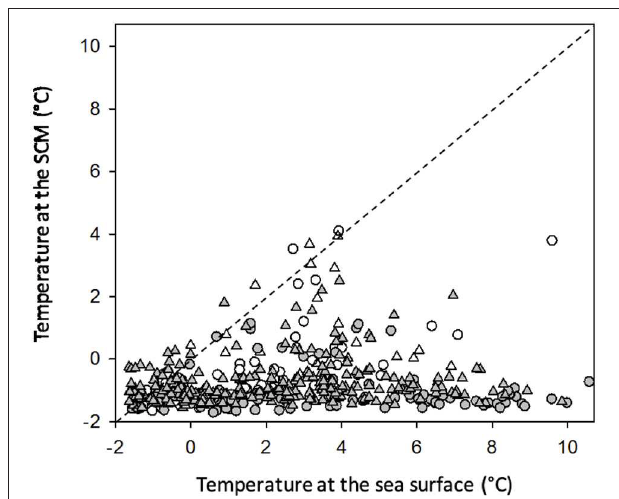
FIGURE 5 | Water temperature at the sea surface and at the depth of the fluorescence maximum for the 547 stations where a clear SCM was present. Sampling locations include the entire Canadian Arctic and cover the period 2005-2018 ( Amundsen Science Data Collection, 2018). Stations were sorted according to the depth of the SCM (below 25 m = closed symbols, above 25 m = open symbols) and the sampling period (prior to 1 August = circles, after 1 August = triangles). The few stations exhibiting elevated temperature at the SCM are anomalies corresponding to stations at which ice retreat was unusually late and the SCM was very shallow. The 1:1 line is for visual